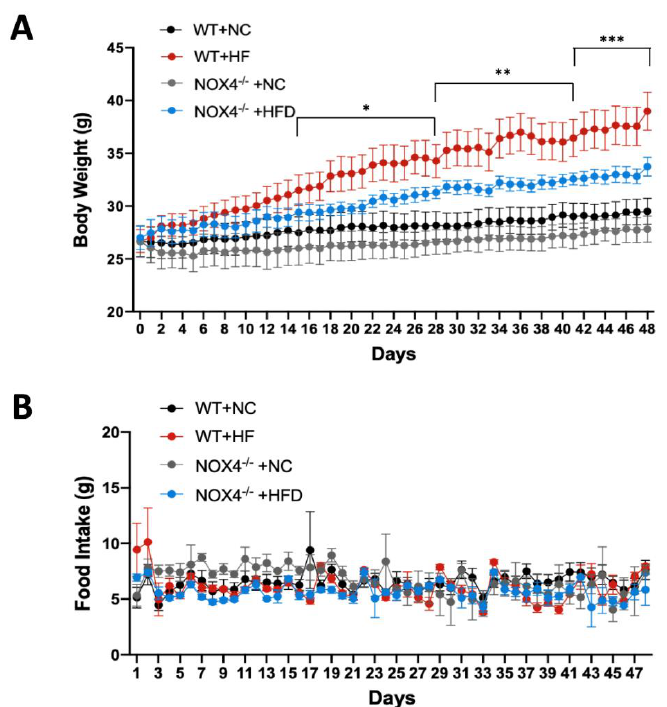
Figure 2. NOX4 deficiency contributes to the alteration of systemic metabolism under HFD. ( A ) Measurement of body weight from Nox4 -/- and wild-type (WT) mice with HFD or NC diet (n = 4 / group). Body weight was measured at same time in every day for seven weeks. ( B ) Measurement of food intake from Nox4 -/- and WT mice with HFD or NC diet (n = 4 / group). Food intake was measured at the same time every day for seven weeks. Data are mean ± standard deviation (SD). ***, p < 0.001, **, p < 0.005, *, p < 0.05 by Student’s two -tailed t -test.